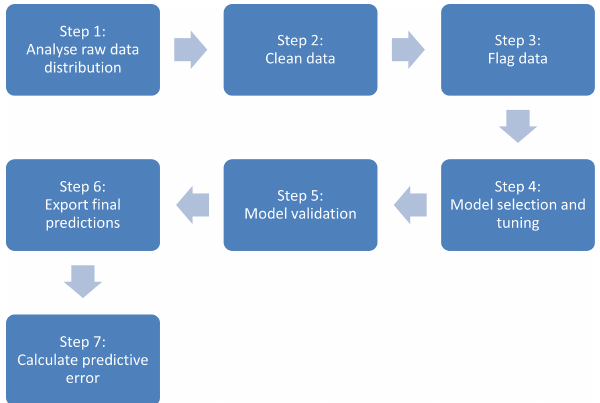
Figure 1. Schematic representation of the seven-step calibration method for processing small sensor system